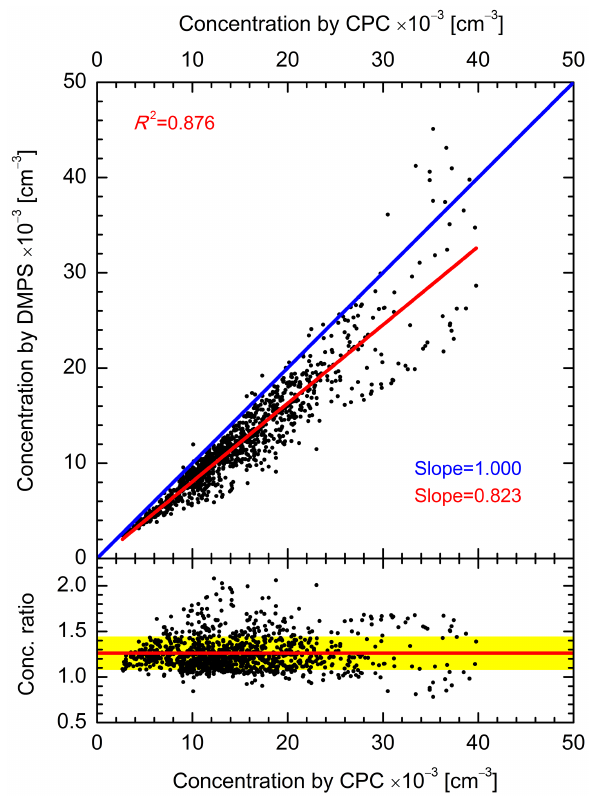
Figure 4. Scatter plot and CPC / DMPS concentration ratios for to- tal particle number concentration data derived from the DMPS sys- tem and from an identical CPC. In the upper panel, the coefficient of determination of the data pairs ( R 2 ), the regression line and its slope are shown together with the equality line. In the lower panel, the horizontal red line and yellow band indicate the mean concen- tration ratio and its standard deviation,